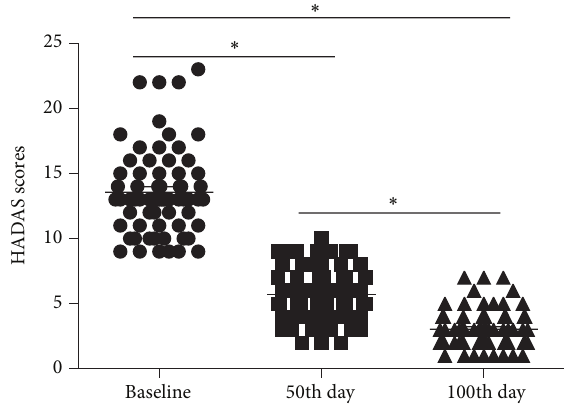
Figure 1: Scores of HADAS subjects. HADAS = high-altitude deacclimatization syndrome. The levels of HADAS scores of subjects tended to decrease as times went on. The dot plots show the levels of HADAS scores at baseline, 50th day, and 100th day. ∗ 𝑝 < 0.05 ; the scores were significant